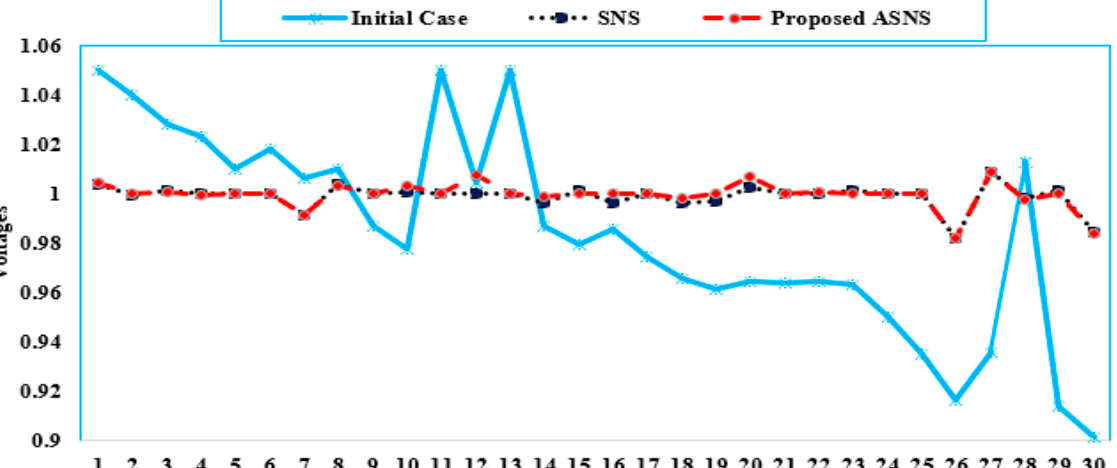
Table 4. Optimal results for Case 3 of the IEEE 30-bus grid.